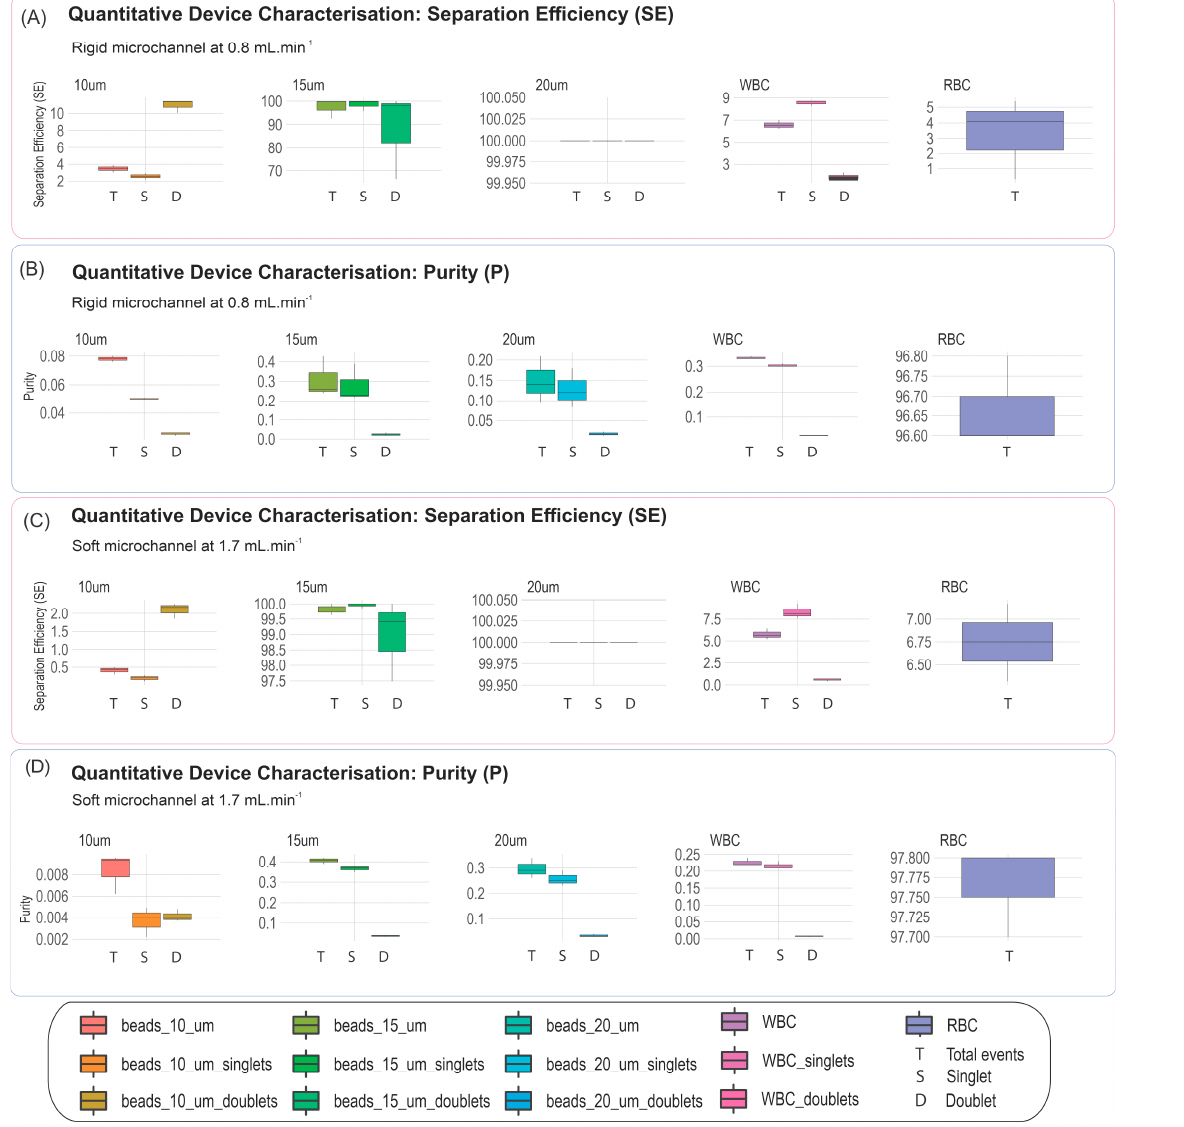
Figure 4. Quantitative assessment of two different devices run at their optimal operational flow rates. SE and P values are calculated for three independent replicates of sample composed of diluted whole blood spiked with 10 μ m, 15 μ m, and 20 μ m beads. ( A , B ) show the SE and P values for a 3D printed chip, while ( C , D ) show the SE and P values for the PDMS spiral chip. Values are calculated for each particle/cell type and have been split by total (T) events for that particle/cell type, singlets (S), or doublets (D)